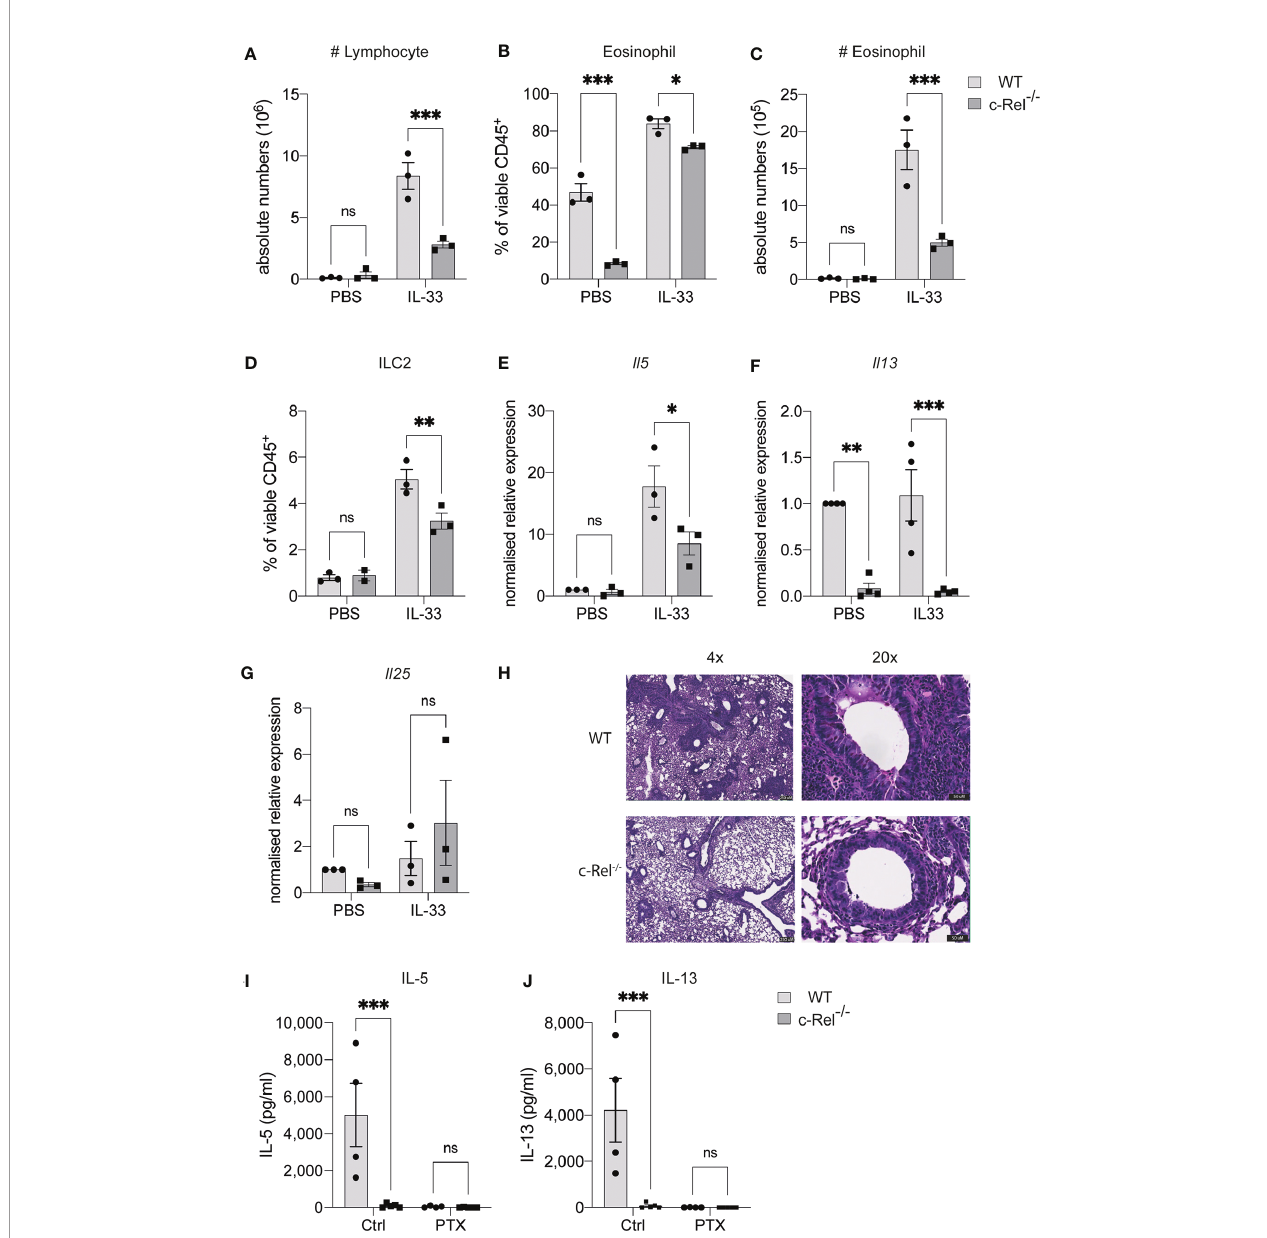
FIGURE 5 | c-Rel is critical for ILC2-mediated lung in fl ammation, induced by IL-33. (A) Absolute numbers of CD45 + lymphocytes in the bronchoalveolar lavage (BAL) fl uid following PBS (control) or rIL-33 administration for three days. (B) Quanti fi cation of Siglec-F + CD11c - eosinophils in BAL among viable CD45 + cells. (C) Absolute numbers of BAL eosinophils. (D) Quanti fi cation of CD127 + KLRG-1 + lung ILC2s (gated on Lin - CD90 + CD25 + ST2 + ) among viable CD45 + cells. (E – G) qPCR analysis of the indicated genes from lung tissue following PBS or rIL-33 administration. (H) PAS-stained lung histology visualized using 4x (left) and 20x (right) magni fi cation. (I, J) ELISA analysis of the indicated cytokine from the supernatant of ex vivo lung ILC2s cultures in the presence of IL-2, IL-7, IL-25 and IL-33, with or without a c-Rel inhibitor, pentoxifylline. All graphs are representative of at least two independent experiments with 3-5 per group. Error bars represent ± SEM. *p ≤ 0.05, **p ≤ 0.01, ***p ≤ 0.001. ns, non-signi fi